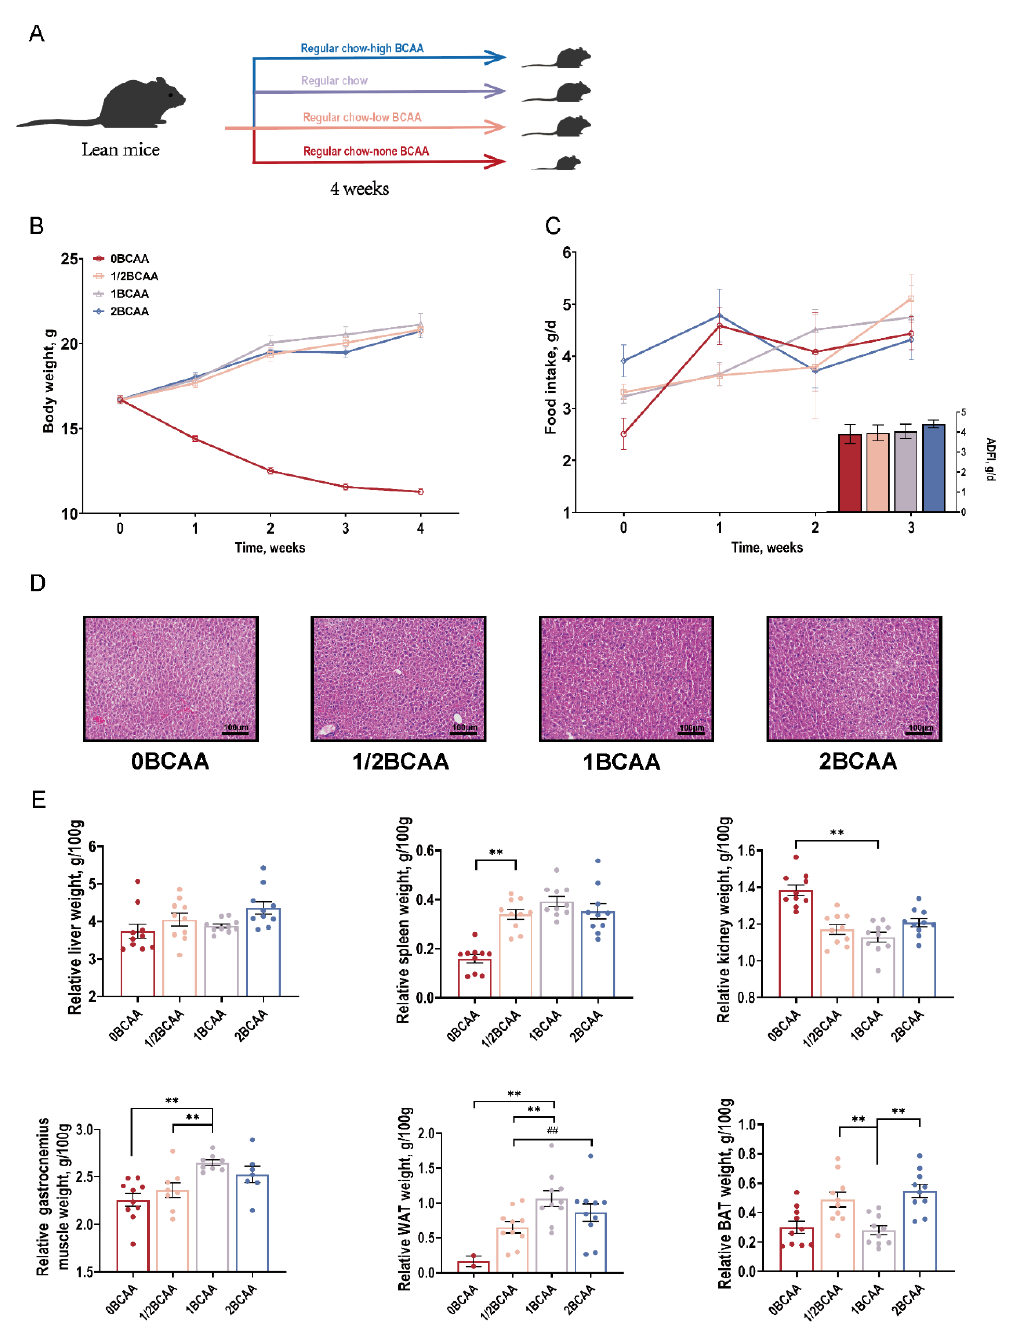
Figure 1. Effects of different dietary BCAA levels on the growth performance and organ development of lean mice. ( A ): Experimental design; ( B ): Body weight curve; ( C ): Feed intake for 4 weeks; ( D ): Representative H&E staining images of the liver; ( E ): Relative organ weight. Values are presented as the means ± SEM (n = 15 of growth performance and ADFI, n = 8 of relative organ weights). ADFI: Average daily feed intake; WAT: White adipose tissue; BAT: Brown adipose tissue. ** p < 0.01 versus 1BCAA group. ## p < 0.01 in 2BCAA group versus 1/2BCAA group.